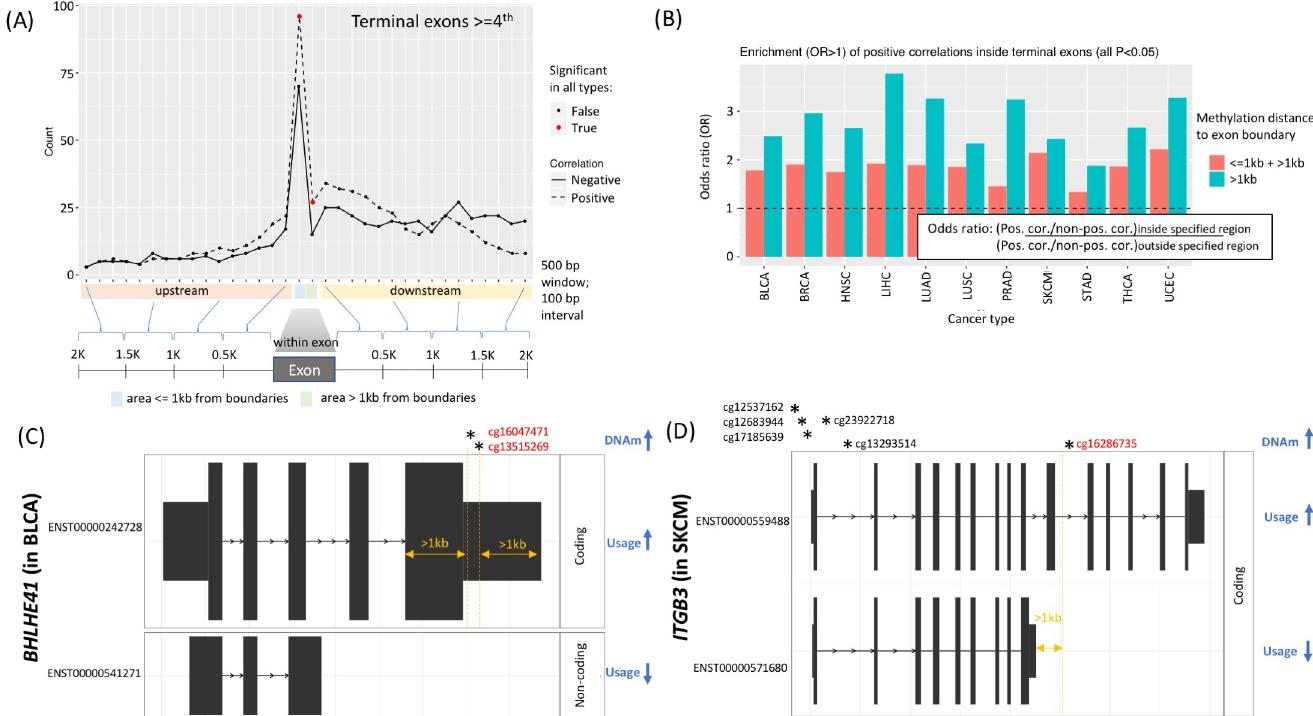
Fig 3. DNAm positioned within the terminal exon or relative to an alternative, downstream terminal exon correlates with inclusion. (A) Median count (across 11 cancer types) of positive and negative correlations between DNA methylation and isoform use was computed for each binned region inside and around the terminal exons in the fourth exon position or beyond (see schematic below plot). Significance across all cancer types is seen only when methylation appears within the terminal exon (red circles). (B) Positive correlations between DNA methylation and isoform use are enriched when DNAm is within terminal exons, both > and < 1 kb from the exon boundaries (OR > 1), especially in long exons where boundaries are more than 2 kb away (blue bars). (C) In bladder cancer (BLCA), DNAm within the exon and far from either exon boundary ( > 1kb) in BHLHE41 is correlated with the inclusion of the long terminal exon, resulting in increased usage of the longer isoform but decreased usage of the shorter one. (D) In melanoma (SKCM), DNAm in ITGB3 that lies downstream of and � 1 kb away from the terminal exon of the shorter isoform is positively correlated with usage of the downstream TTS located in the longer isoform, but negatively correlated with the shorter isoform. Five CpG sites (asterisks) near the transcription start site are also positively correlated with the longer isoform but negatively correlated with the shorter